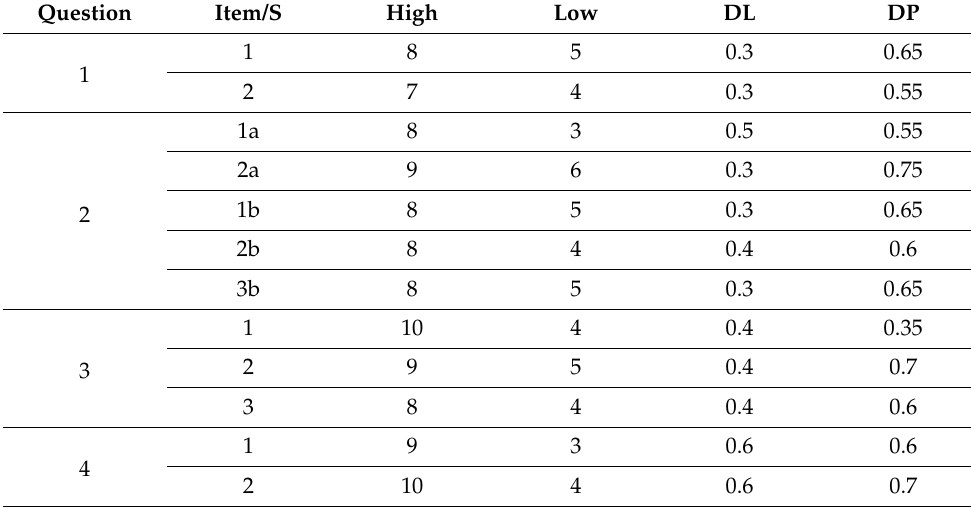
Table 10. The Difficulty Level and Discrimination Power of Posttest Items.